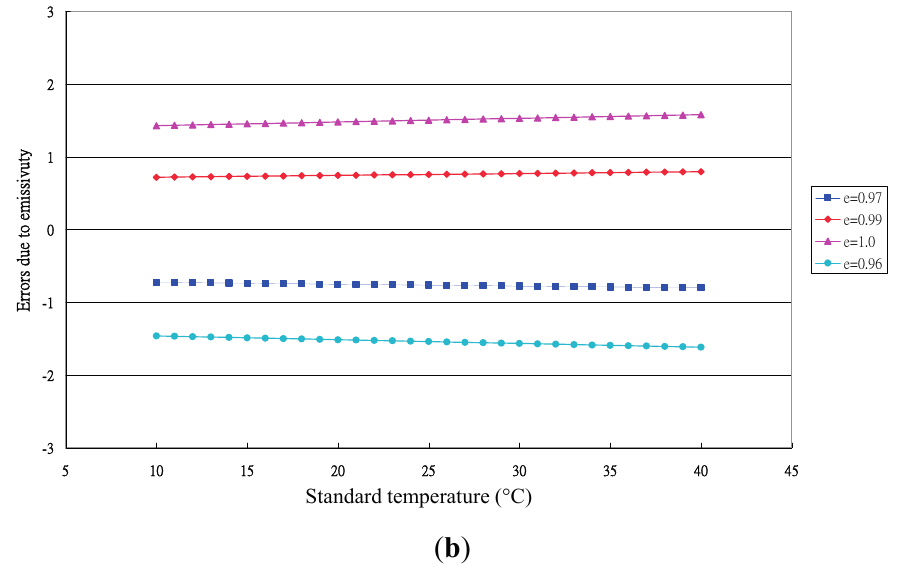
Figure 6. The effect of the emissivity settings on measurement errors for crop leaves. ( a ) Emissivities were assumed as 0.975, 0.985 and 0.965; ( b ) Emissivities were assumed